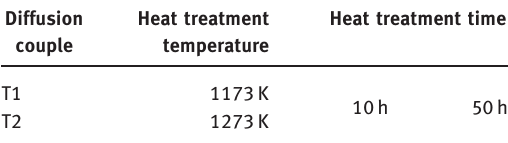
Table 2: Experimental heat-treatment conditions.